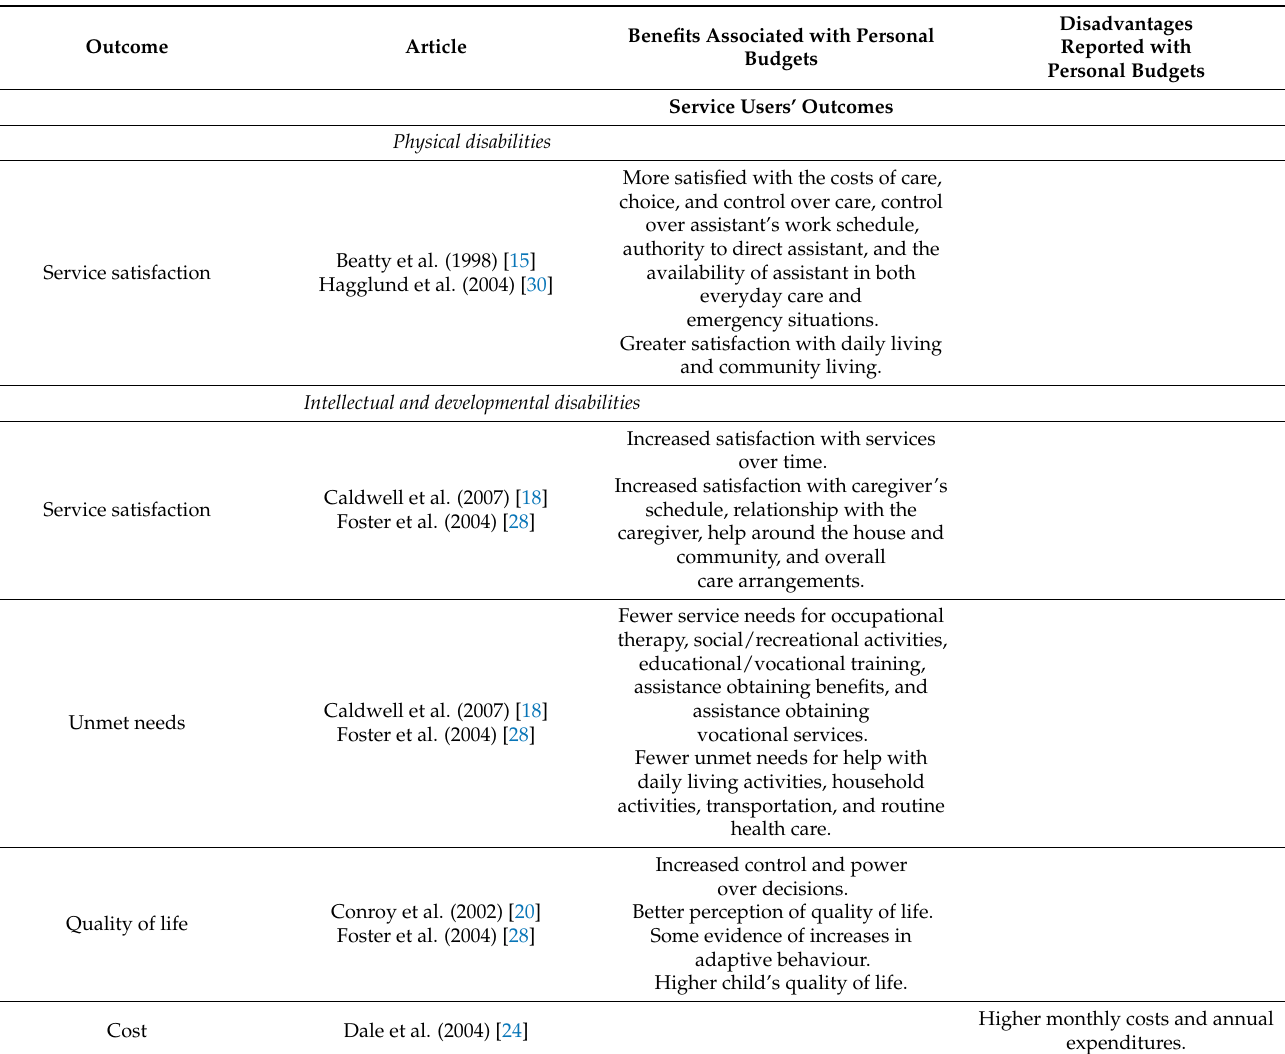
Table 4. Benefits and disadvantages associated with personal